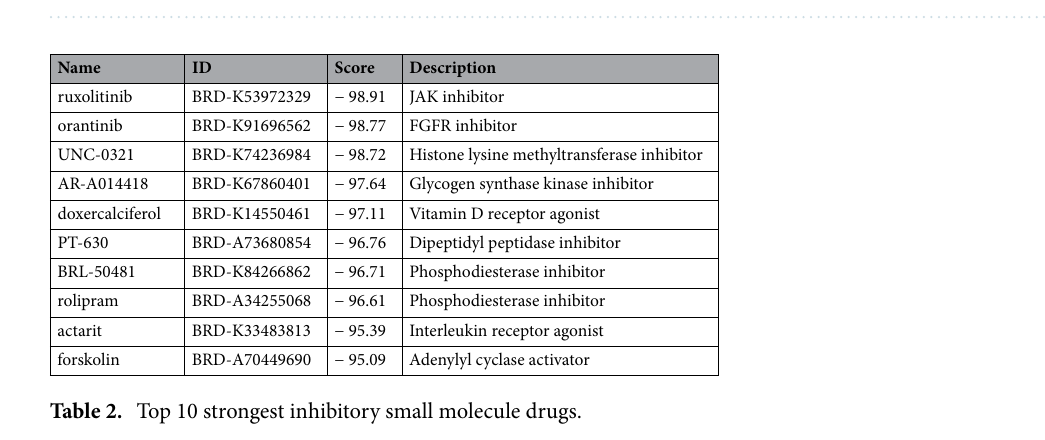
Figure 8. Analyses of immune checkpoints, small molecule drug therapy, GO, as well as KEGG Pathway in two m5Cclusters. ( A ) The boxplot of immune checkpoints in the two m5C patterns. * p < 0.05, ** p < 0.01, and *** p < 0.001. ( B ) The expression of PDCD1 (PD-1) in the two m5C patterns. ( C ) The expression of CD274 (PD-L1) in the two m5C patterns. Two-dimensional molecular structure ( D ) and three-dimensional molecular structure ( E ) of ruxolitinib. The GO ( F ) and KEGG ( G ) enrichment analysis for the m5C-related differentially expressed genes (DEGs).